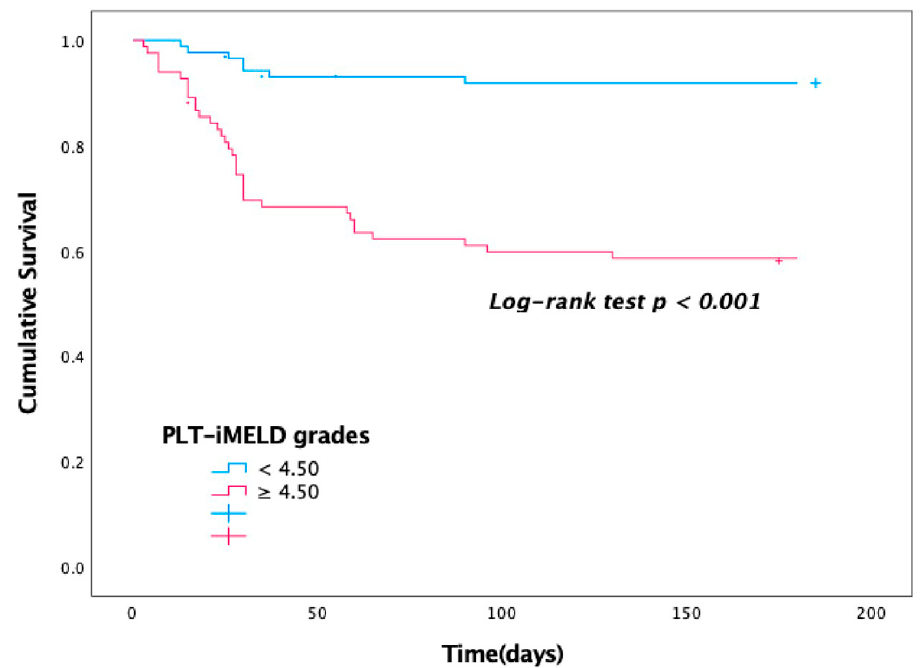
Figure 2. Kaplan–Meier curve for survival at 180 days among pediatric HBV-ACLF patients after PE. Kaplan–Meier curve for survival stratified by PLT-iMELD score < 4.50 and ≥ 4.50. PLT-iMELD: platelet-integrated MELD.